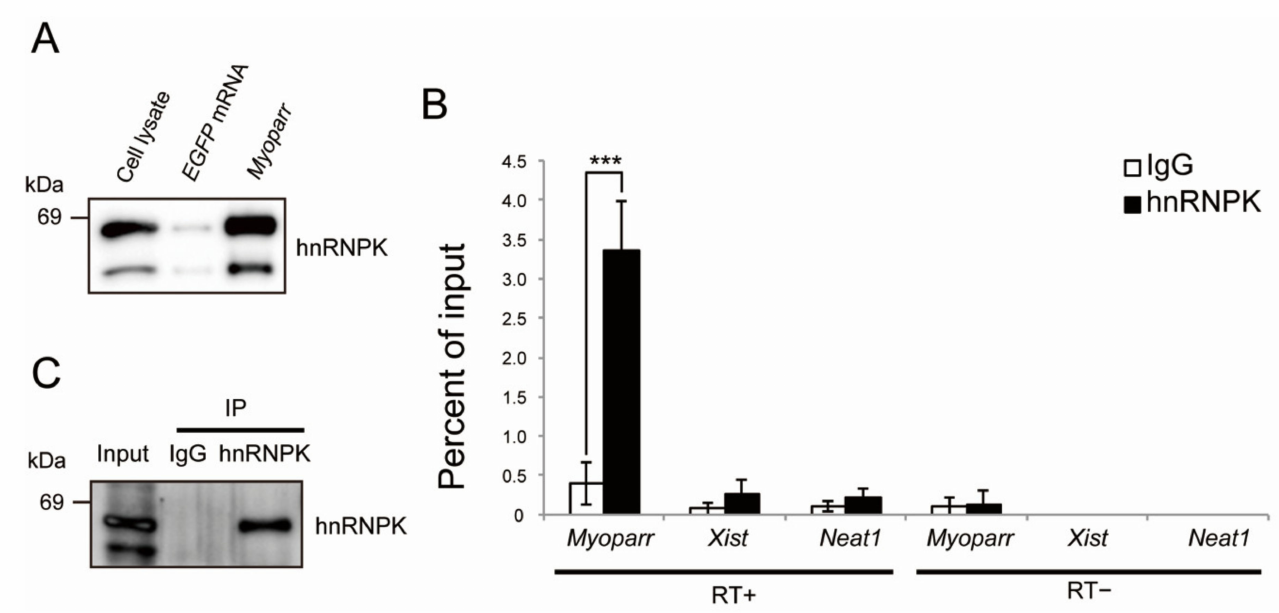
Figure 1. Intracellular interaction between Myoparr and hnRNPK in differentiating C2C12 cells. ( A ) Synthesized Myoparr was mixed with the C2C12 nuclear extract. Following purification of